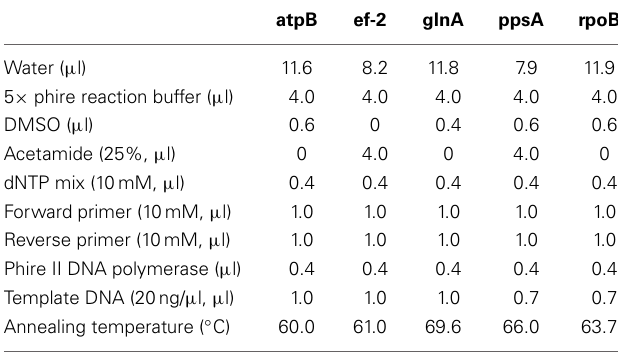
Table 2 | PCR conditions for each